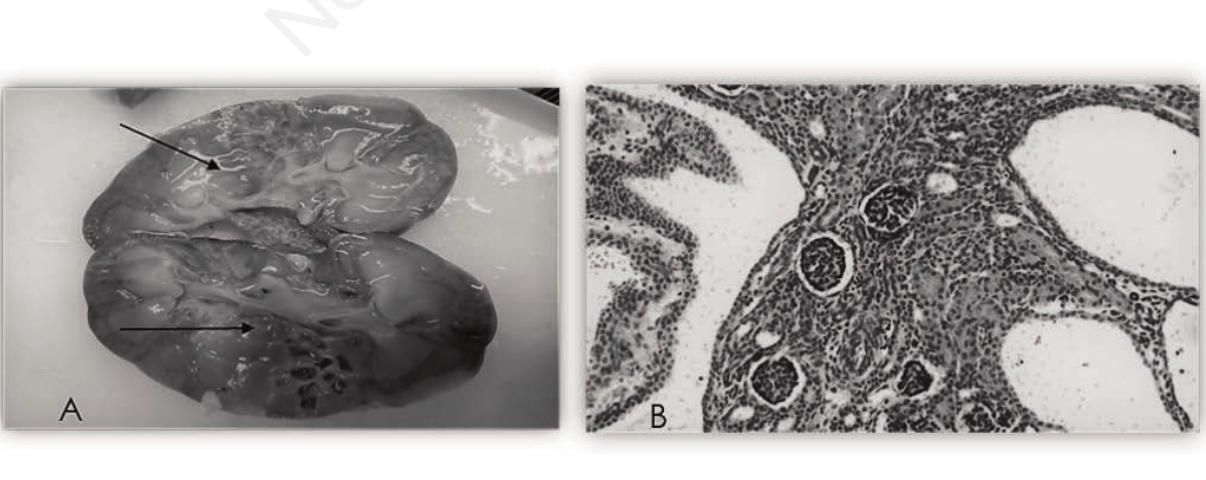
Figure 2. A. Gross histopathological specimen image demonstrating the cysts of the LCDK lesion (black arrows) B. Microscopic view after hematoxylin/eosin staining demonstrating normal renal parenchyma between the